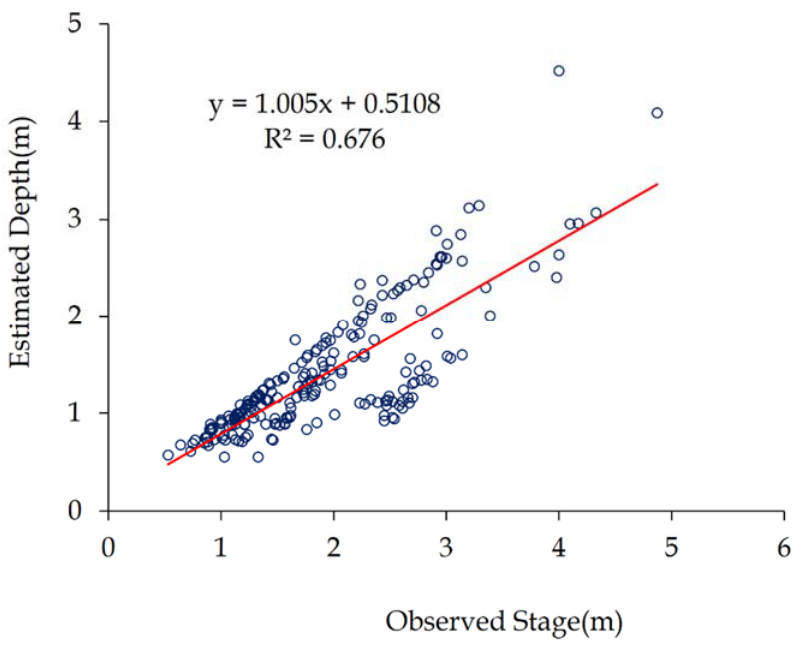
Figure 8. Observed stage and estimated average depth (using Equation (4)) at Lhasa gauging station. The strong correlation demonstrates the accuracy of our average depth estimation methodology.